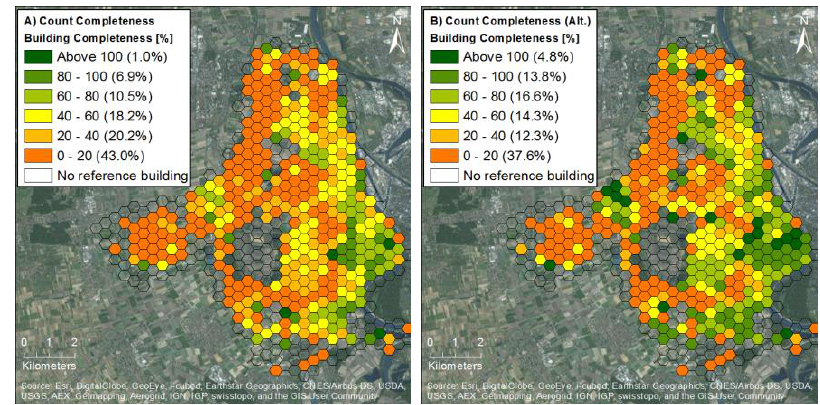
Figure 4. Building completeness in OSM estimated with the percentage of the building count ratio (A) and an alternative method including pre-processing of the data